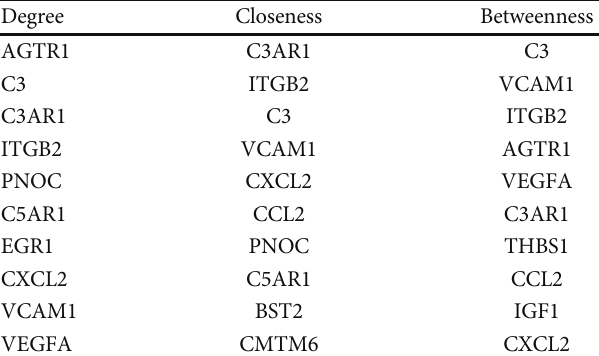
Table 3: Top ten nodes in topological analyses of degree, betweenness, and